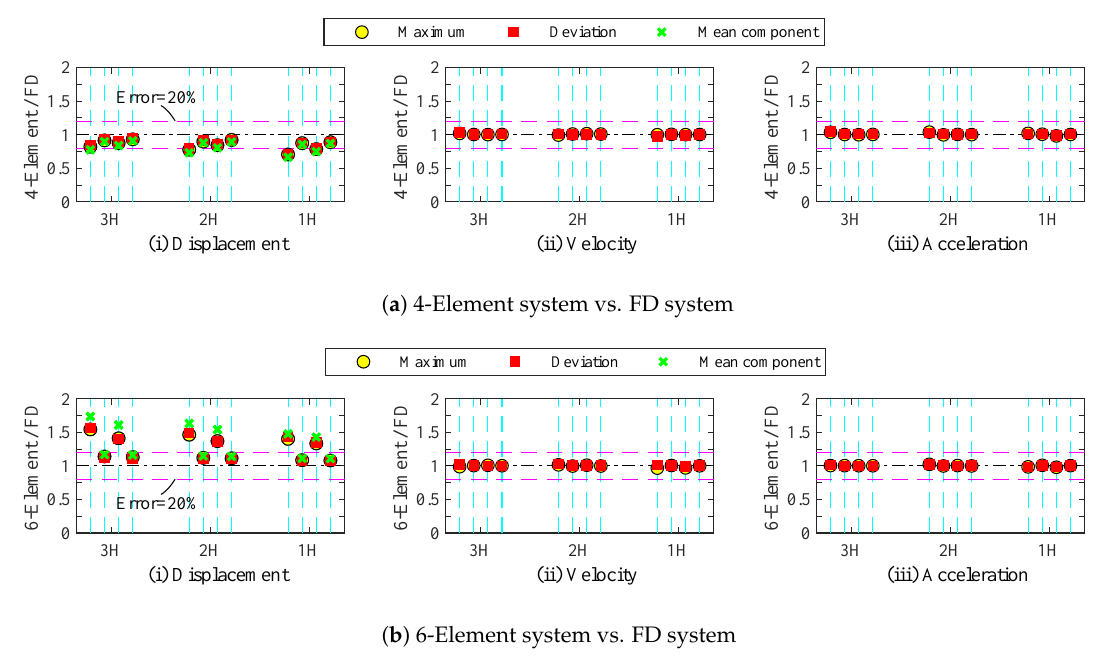
Figure 18. Ratio of wind-induced responses (along-wind): (HH, SH, HS, SS from left to right of each frame).